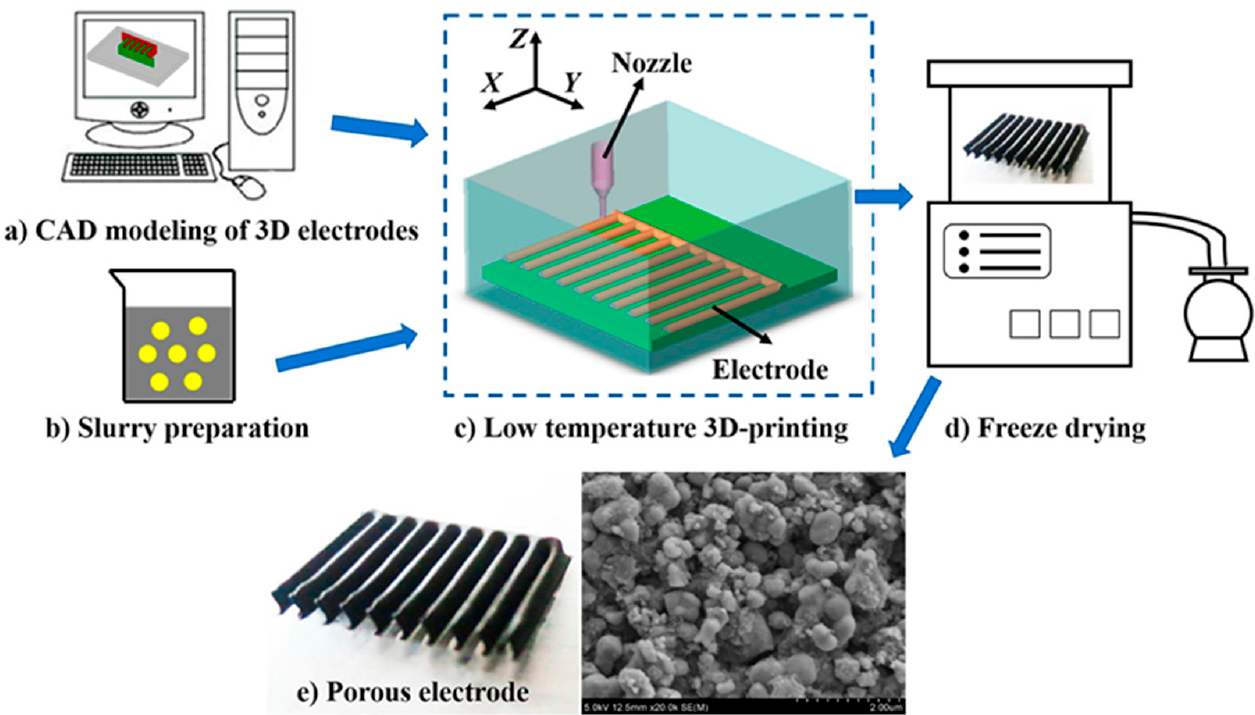
Figure 9. Manufacture of LiFePO4 (LFP) electrode by low temperature direct writing (LTDW). ( a ) Computer-added design (CAD) modeling of 3D electrodes, ( b ) slurry making, ( c ) low temperature direct writing, ( d ) freeze-drying step, ( e ) obtained porous electrodes. Reprinted with permission from Ref. [93], Copyright 2017 by the authors and licensee MDPI, Basel, Switzerland.